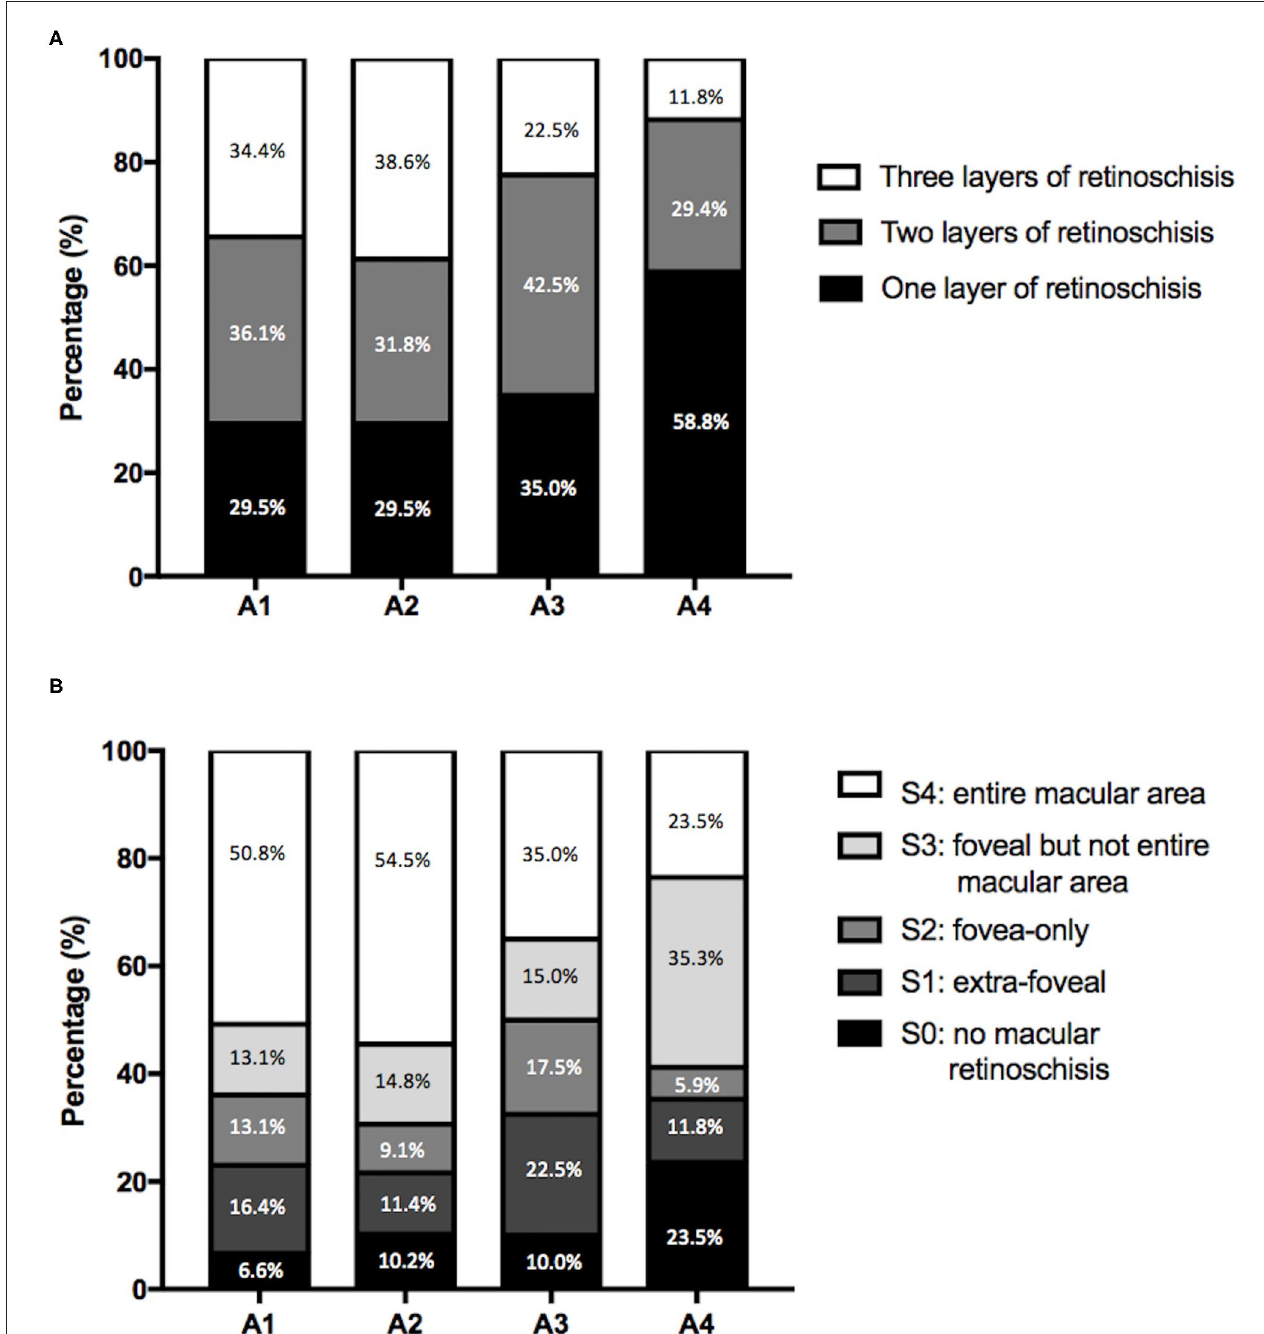
FIGURE 2 | Features of myopic retinoschisis in different myopic atrophy maculopathy (MAM) grades. (A) Distributions of numbers of retinoschisis layers in different MAM grades. (B) Distributions of the range and location of outer retinoschisis in different MAM grades. A1, tessellated fundus; A2, diffuse chorioretinal atrophy; A3, patchy chorioretinal atrophy; A4, macular